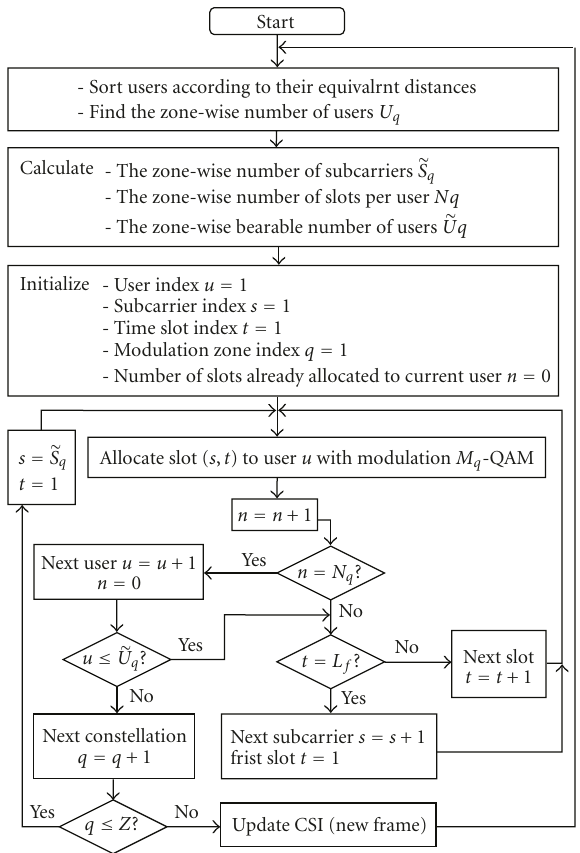
Figure 5: Flow chart of the resource allocation online step.